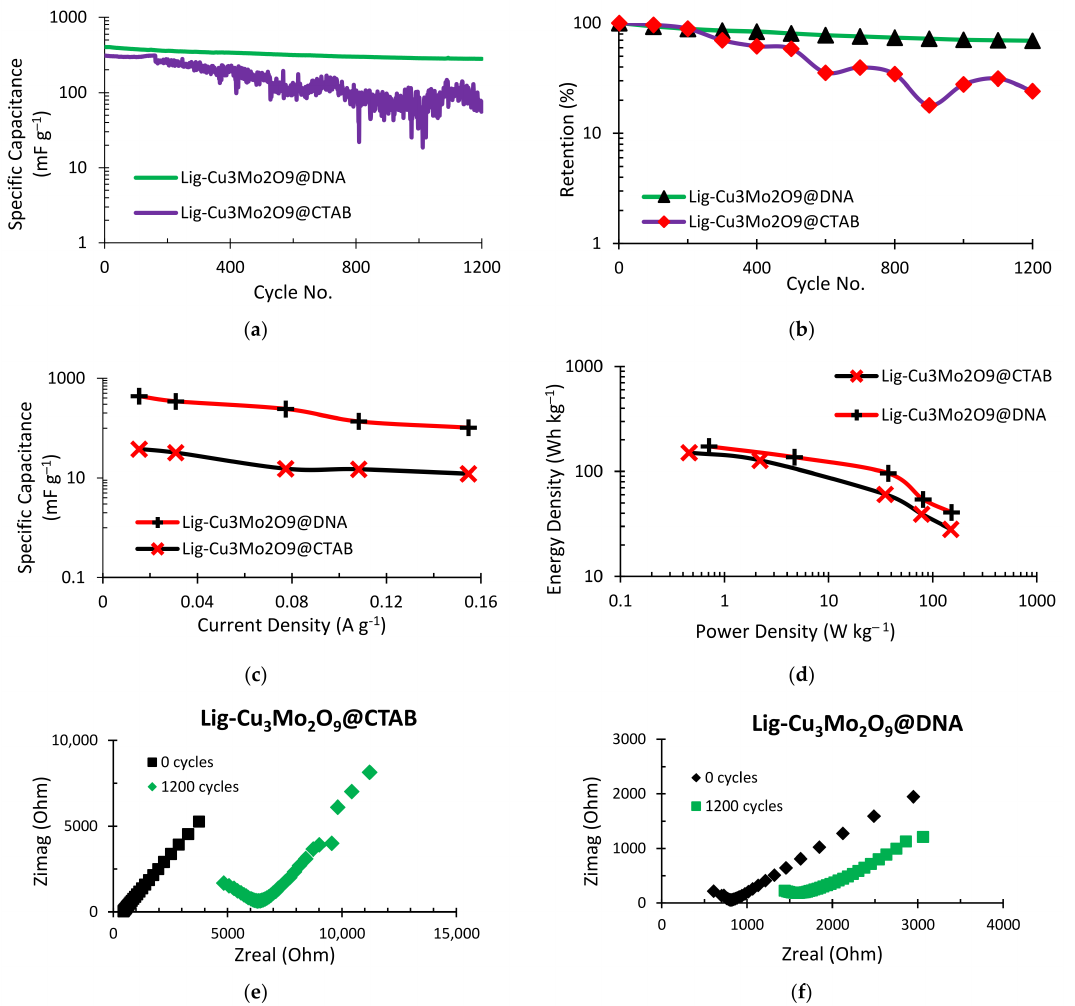
Figure 7. CCD plots for ( a ) specific capacitance vs. cycle no.; ( b ) retention (%) vs. cycle no.; ( c ) specific capacitance variation with current density; ( d ) Ragone plot obtained via CCD; ( e ) comparative